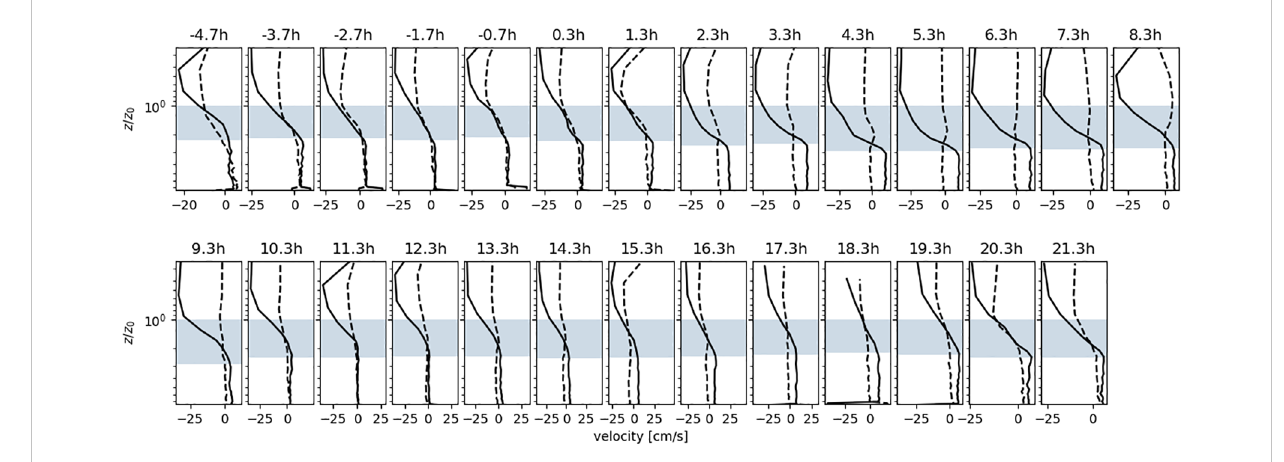
FIGURE 5 Velocity pro fi les on hourly intervals for eastern (dashed) and northern (solid lines) components. Shading marks the interval between z0 and zf, interpreted as constant- fl ux